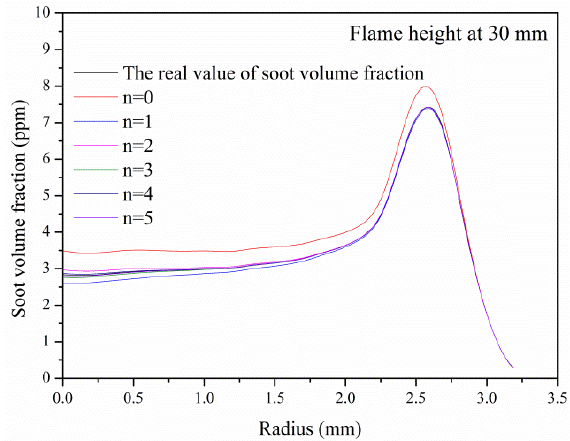
Figure 3. Updated trend value of the soot volume fraction at a height of 30 mm during iterations.